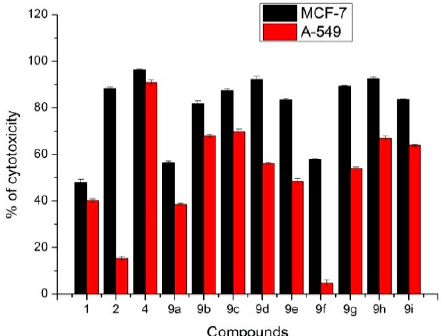
Figure 1. Screening the cytotoxic activities of compounds, in vitro, against human tumor cell lines: breast carcinoma (MCF-7) and human lung carcinoma (A-549 cell line). Preliminary concentration for screening was 100 ppm. Each result is a mean of 3 replicate samples.